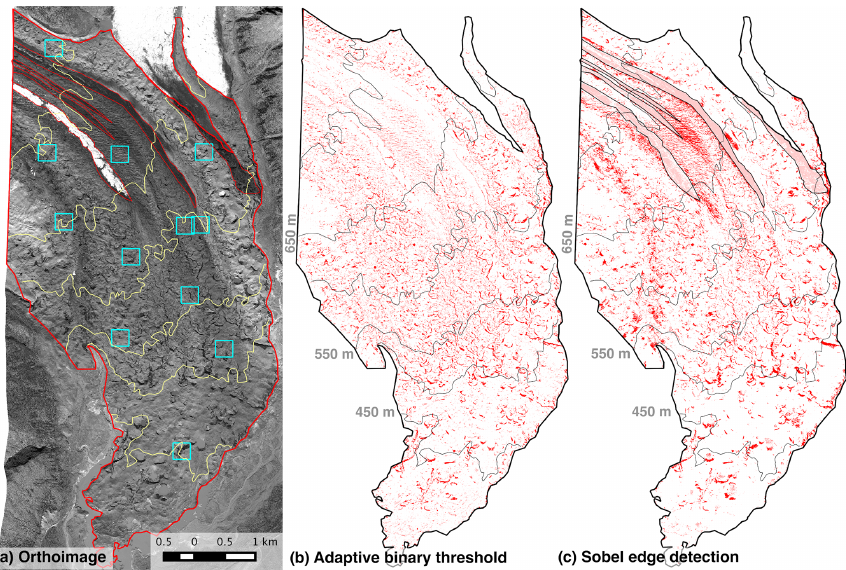
Figure 9. Results from the two ice cliff delineation methods. (a) Orthoimage of the terminus of Kennicott Glacier with the debris-covered area used for distributed melt estimates outlined by the thicker red line. The thinner red lines show regions of dark and light bare ice that required special treatment for the SED method. Thin yellow lines are elevation contours with a 50m contour interval from 2013. Blue boxes show the locations of manually digitized ice cliff area, used for error analysis and parameter optimization. (b) Ice cliff spatial distribution as estimated by the adaptive binary threshold (ABT) method. The outlines in panels (a) and (b) show the area used for distributed melt calculations. (c) Ice cliff spatial distribution as estimated by the Sobel edge delineation (SED) method, with overlaid elevation contours from